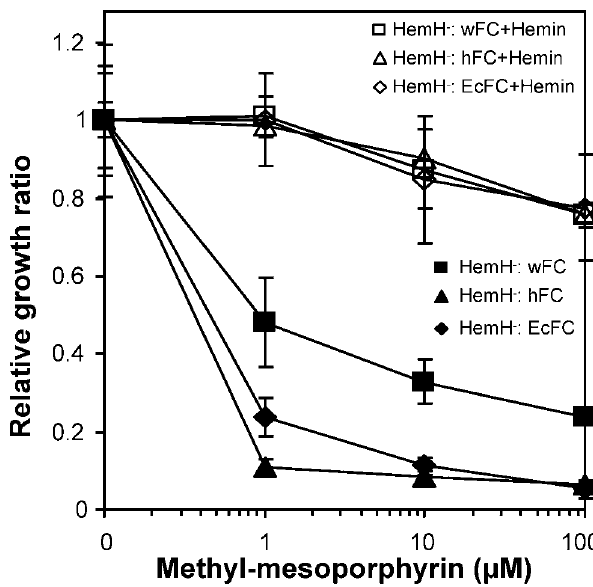
Figure 8. Growth inhibition assays by N-methyl mesoporphyrin (NMMP) of E.coliHemH mutants complemented with human, Wolbachia or E.coli FC genes. The average cell growth rate (final OD 600 /0.01) for untreated control is set as 1.0.